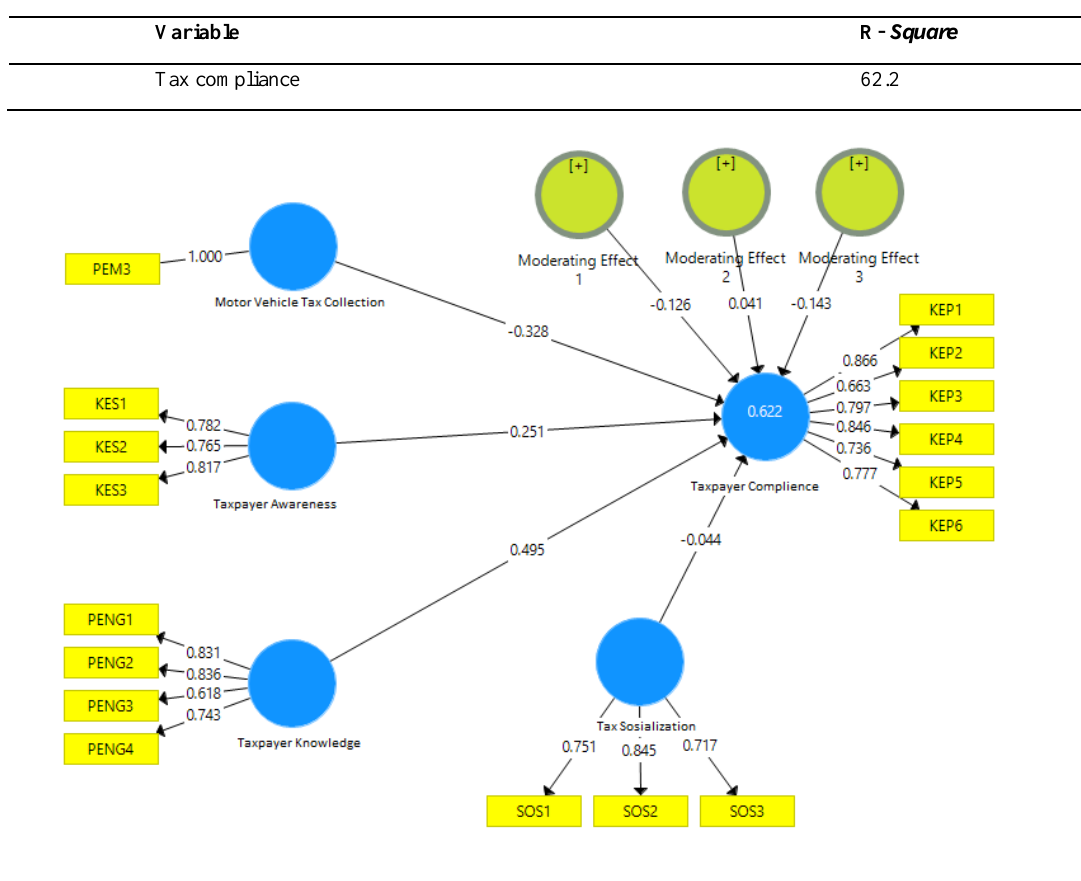
Figure 2: The Running Structural Equation Model 2